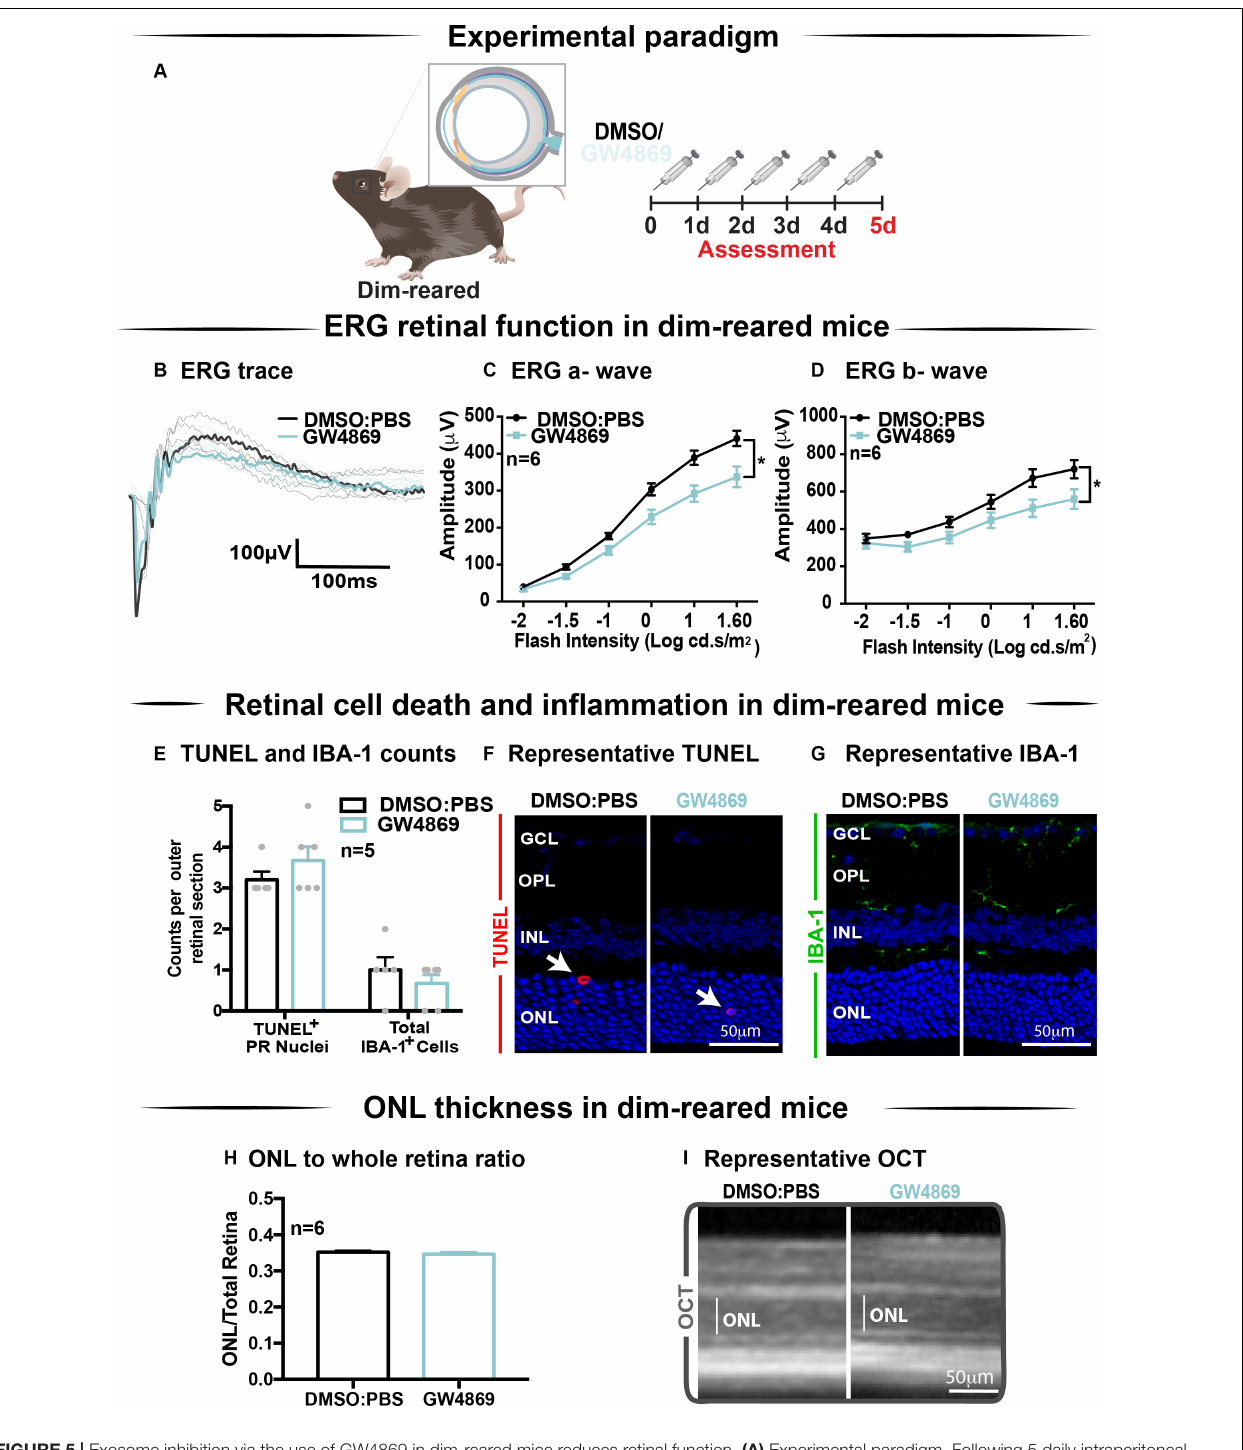
Frontiers in Cellular Neuroscience |